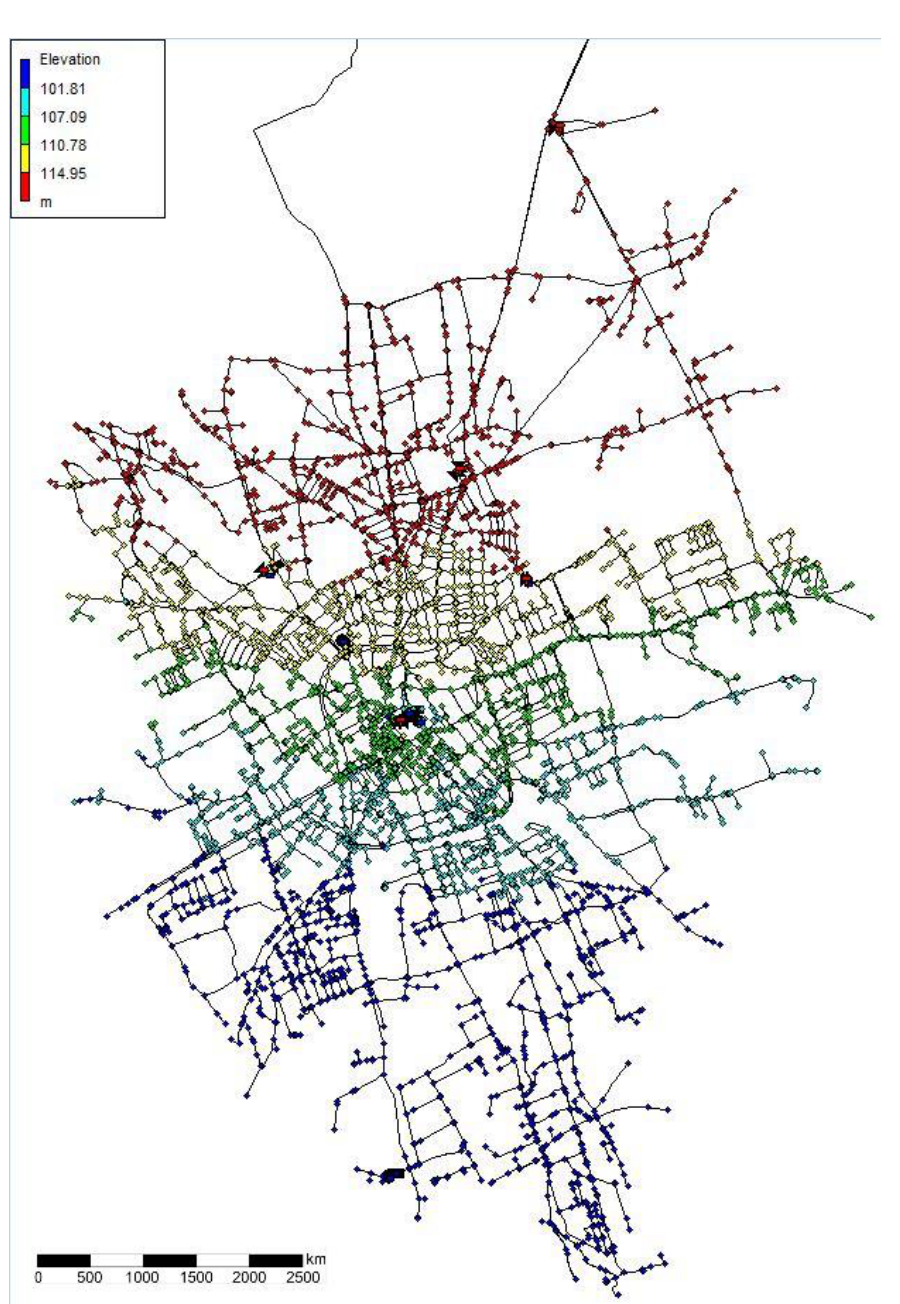
Figure 2. Hydraulic model of the Udine water distribution network.